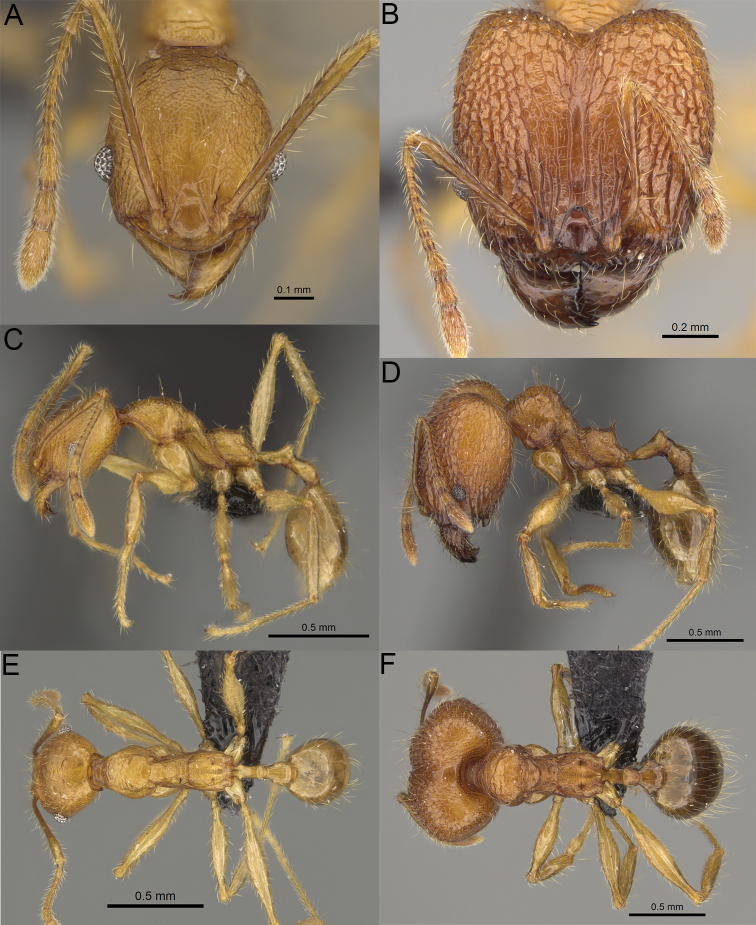
Pheidole
befotaka sp. nov., full-face view (A), profile (C), and dorsal view (E) of paratype minor worker (CASENT0235125) and full-face view (B), profile (D), and dorsal view (F) of holotype major worker (CASENT0119590).